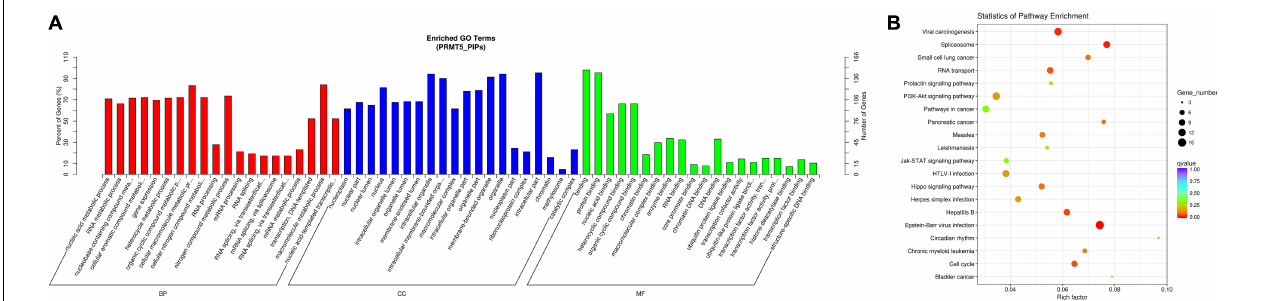
FIGURE 1 | Functional GO and KEGG pathway enrichment analysis of PRMT5 interacting proteins. (A) Plots of significantly enriched GO terms of PRMT5 interacting proteins for biological processes (BP), cellular components (CC) and molecular function (MF). (B) Significantly enriched KEGG pathway terms of PRMT5 interacting